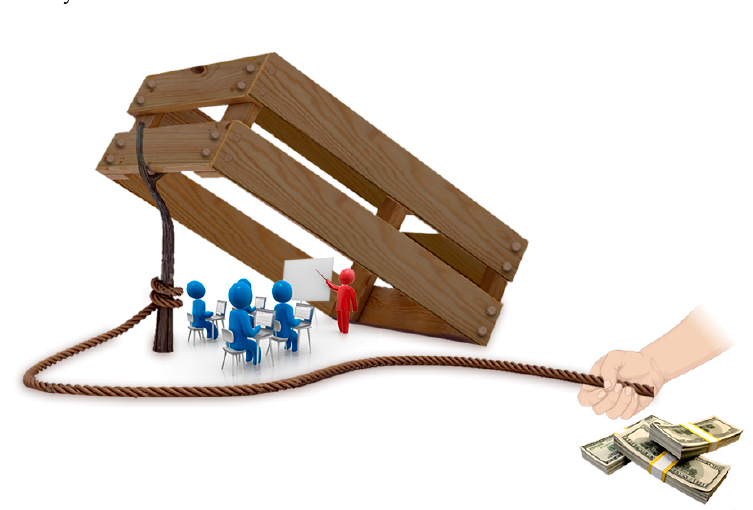
Figure 1. Predatory conferences target scientists. In practice, predatory conferences quickly accept even poor quality submissions without peer review and without control of nonsensical content, while asking for high attendance fees. They may utilize conference names that are similar to the names of more established conferences to attract academics and promote meetings with unrelated images copied from the Internet.